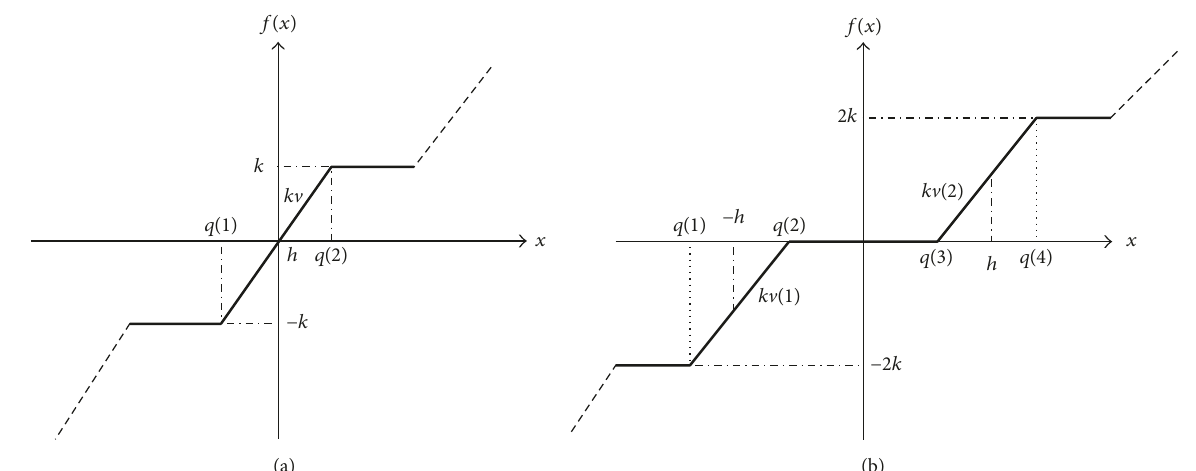
Figure 1: Description of a typical SNLF function for generating (a) even and (b) odd scrolls.